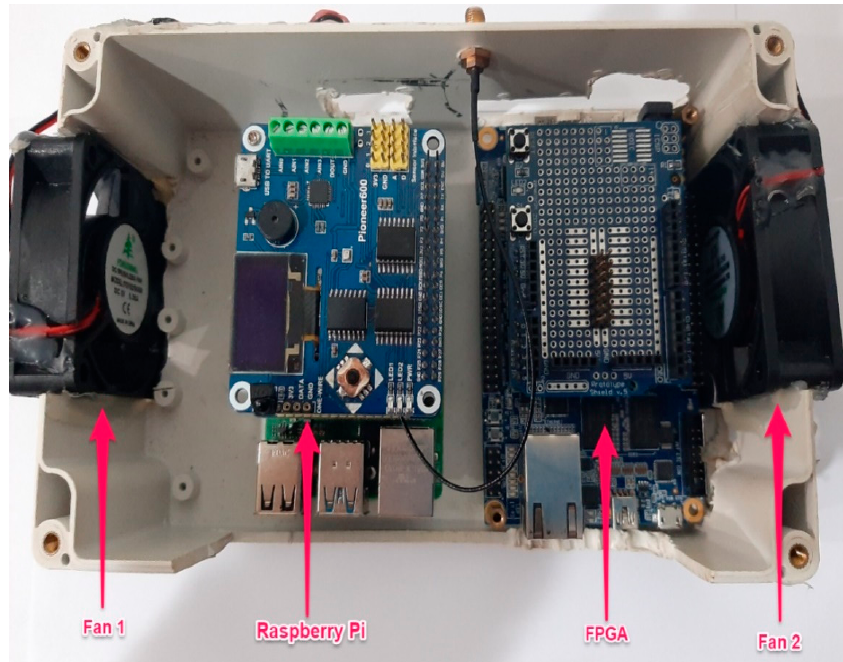
Figure 9. Data collection box.